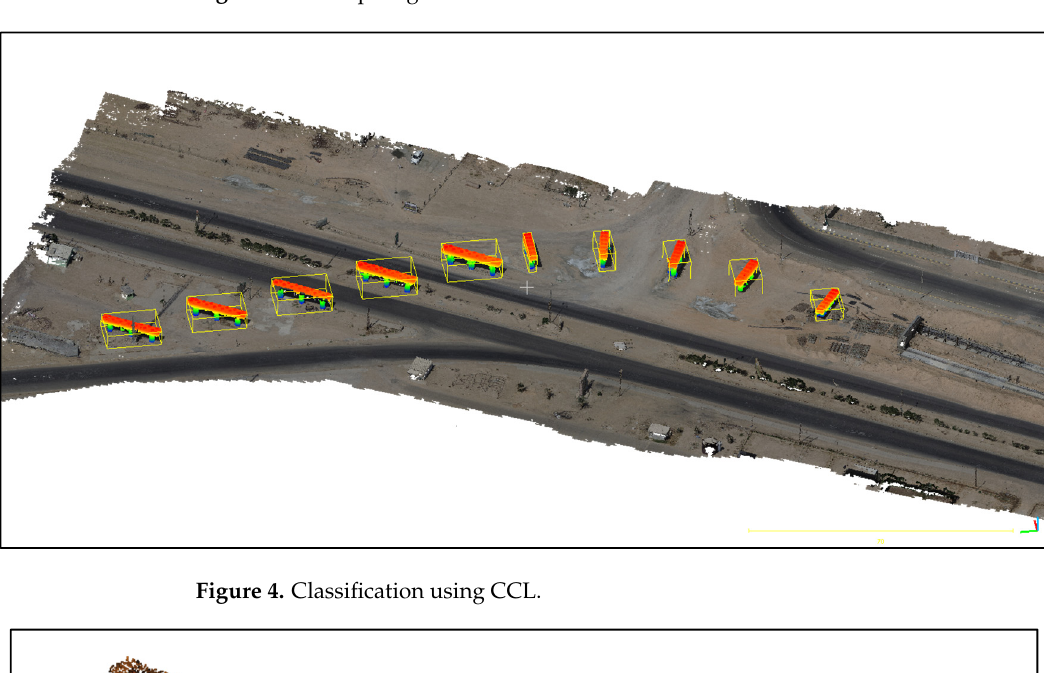
Figure 4. Classification using CCL.